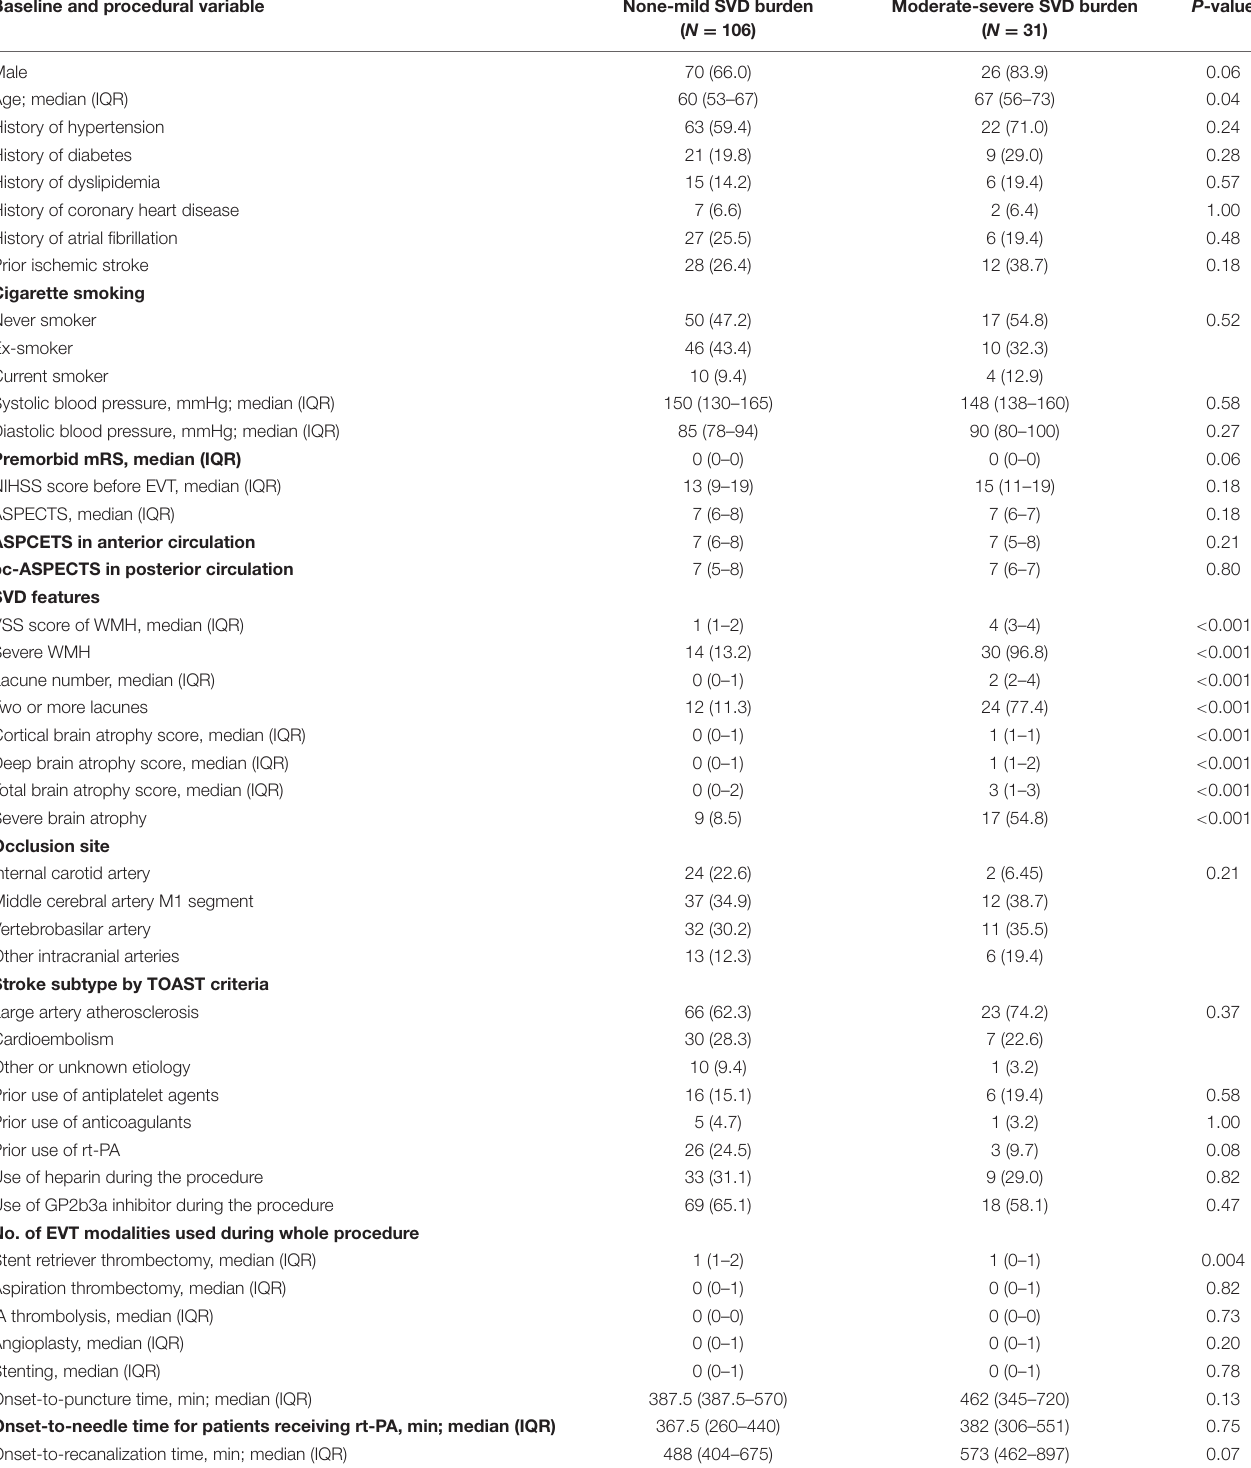
TABLE 1 | Baseline and procedural characteristics of patients with different SVD